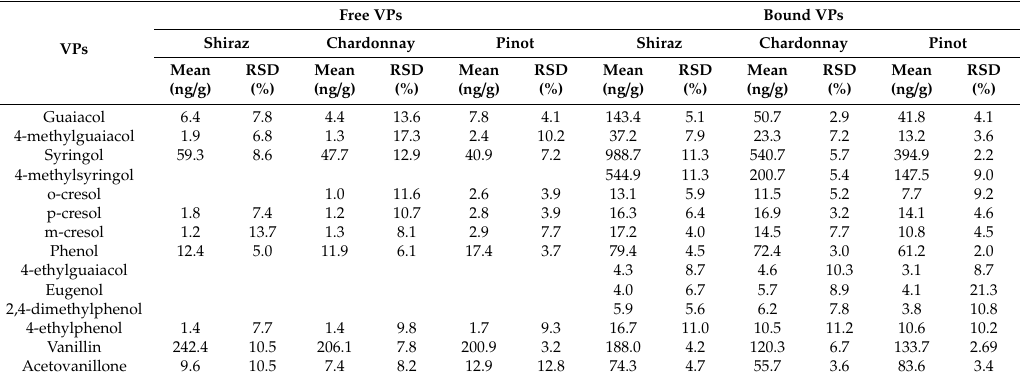
Table 4. Analytical precision (RSD, n = 5) for free and bound VPs in three grape cultivars.